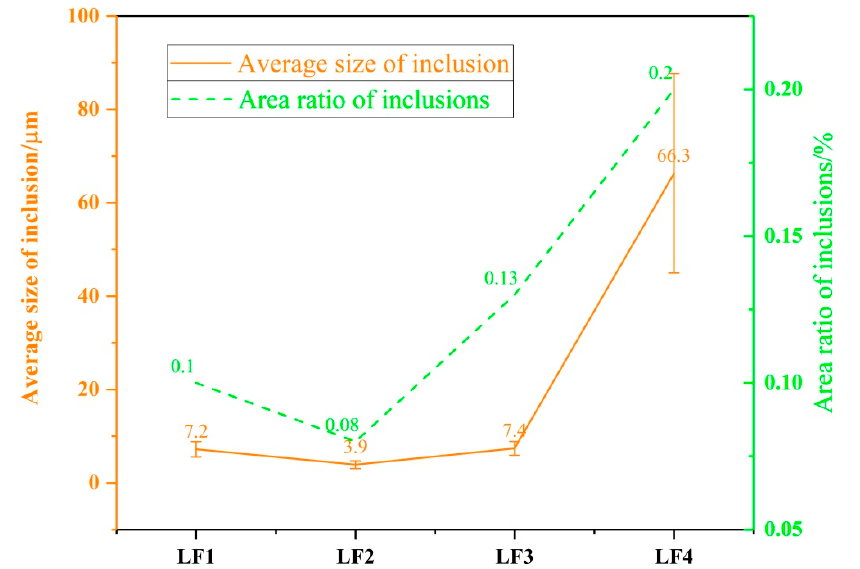
Figure 2. Graph showing trends in the changing inclusion size and the proportion of the inclusion area.